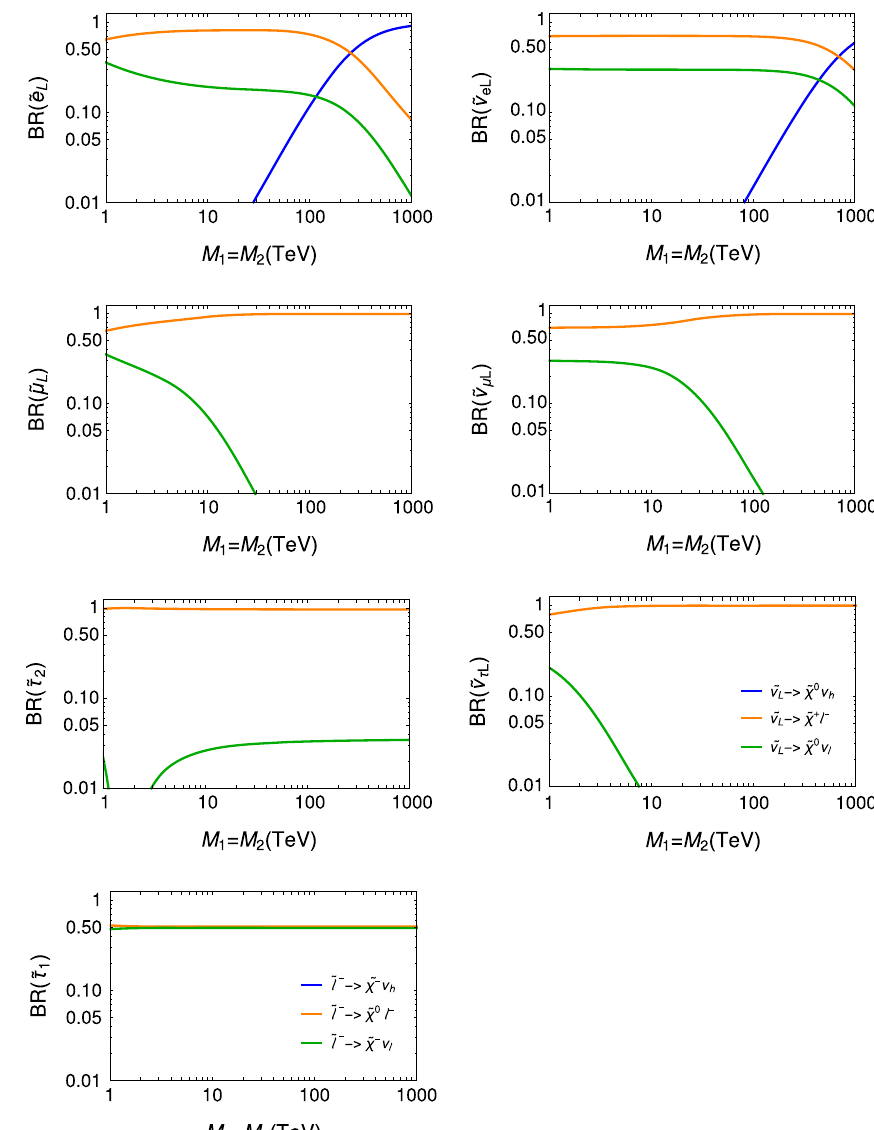
Fig. 2 Branching ratios for sleptons as a function of gaugino mass M 1 = M 2 , for μ < m ˜ Decays for charged L sleptons (sneutrinos) are shown on the left (right) column. The last panels describe the colors for the branching ratios shown in each column. In the case of neutralinos, the sum over the two lightest states is